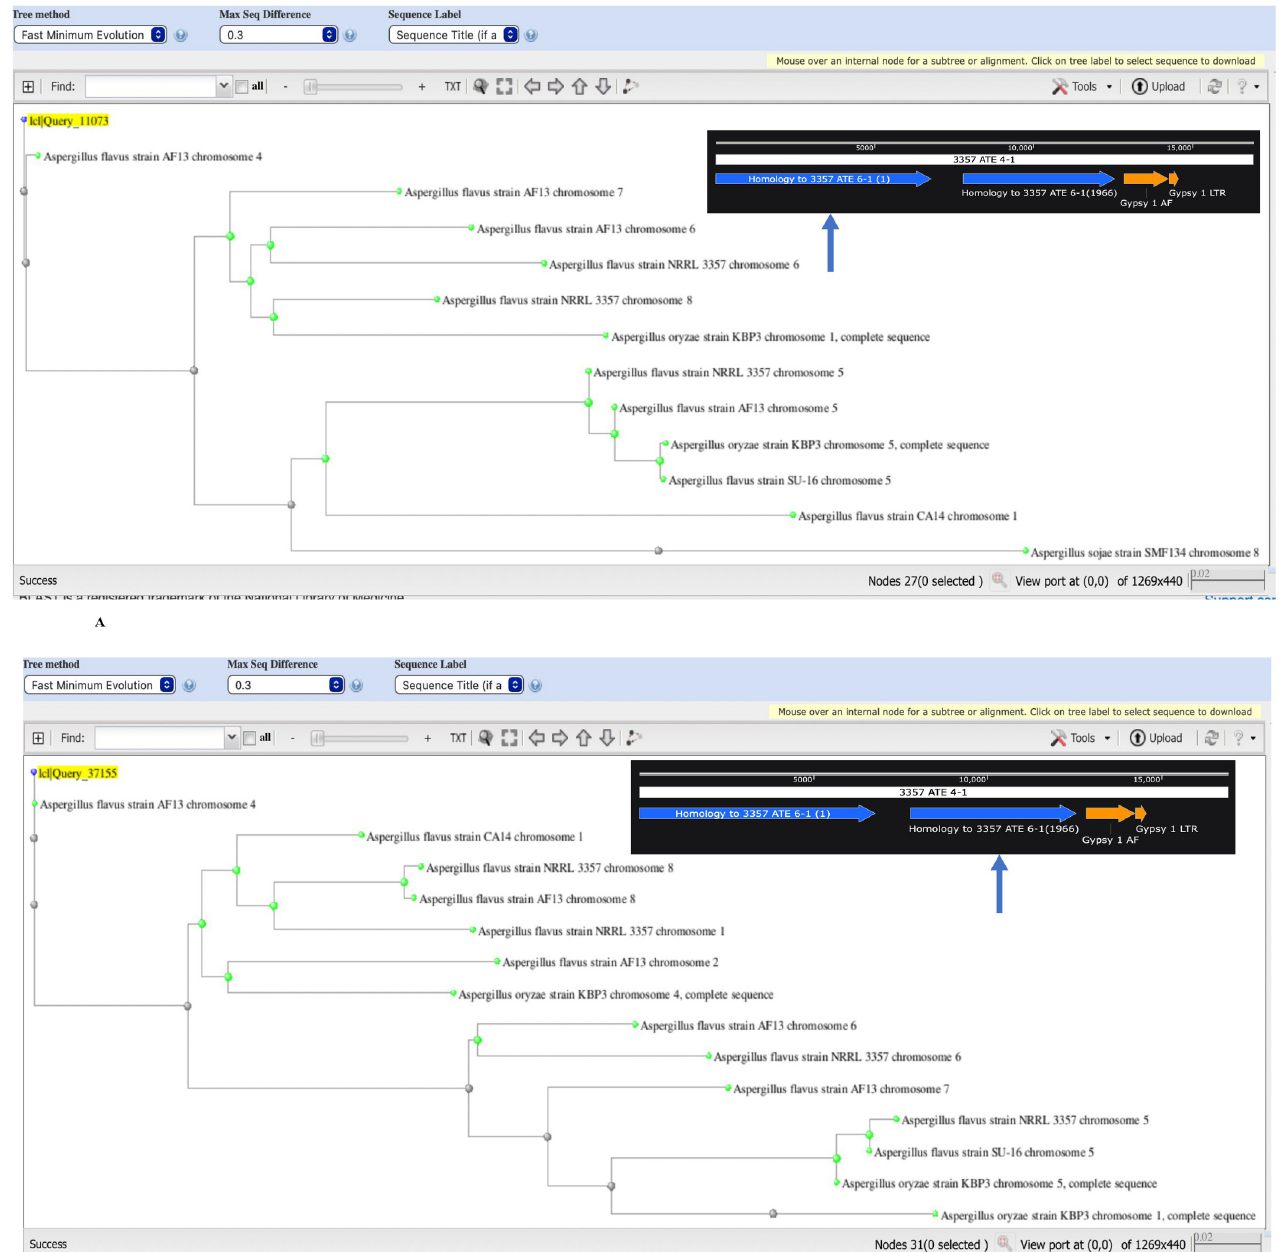
Fig 6. Evolutionary relationships between the left and right class H